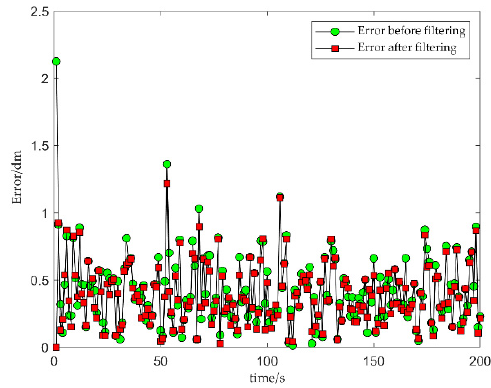
Figure 4. Filter performance.